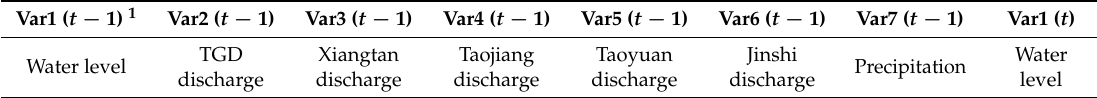
Table 3. Converting variables to a supervised dataset for the LSTM